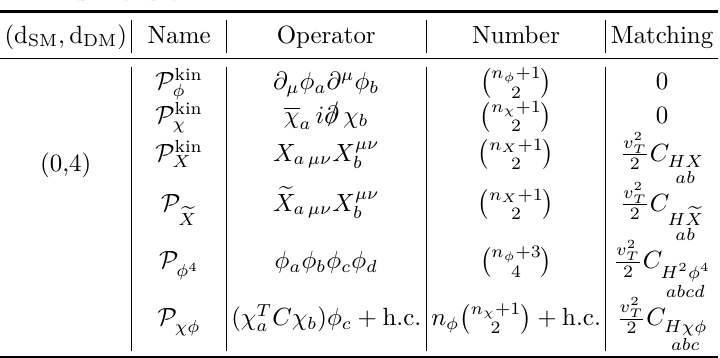
Table 5 . Dimension-four purely DM operators present in DSMEFT and DLEFT. The first column gives the dimensions of the SM and DM part of the operator, the fourth column is the number of operators, and the fifth column is the additional matching contribution at the EW scale. The first three operators are the DM kinetic energy terms.